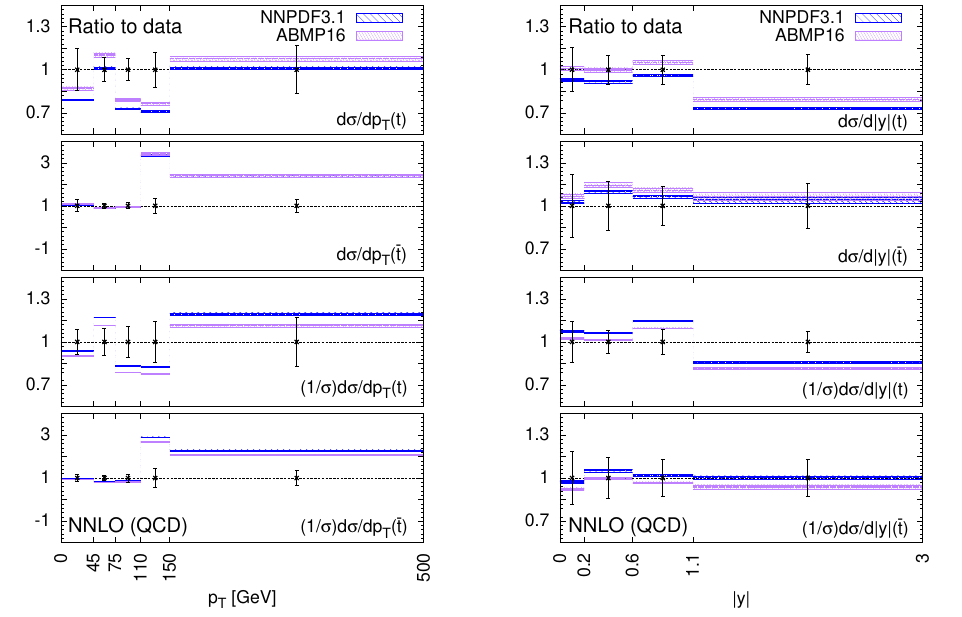
Figure 5 . The t -channel absolute and normalised single top-(anti)quark distributions di(cid:11)eren- tial in the transverse momentum (left) and rapidity (right) of the top-(anti)quark (left). The measurements are compared to NNLO QCD theoretical predictions obtained either with the NNPDF31 nnlo as 0118 or the ABMP16als118 5 nnlo PDF sets. The data and the theoretical pre- dictions are normalised to the central value of the